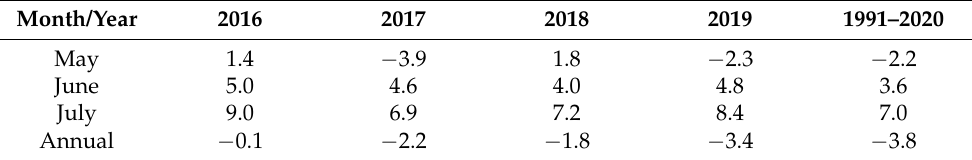
Table 1. Monthly and annual temperature (°C) for the meteorological station at Svalbard Airport (station number 99840), located close to Longyearbyen (Figure 1). Temperatures for the years with S2 data used in this study compared to the 1991–2020 normal period (Norwegian Meteorological Institute 2021).